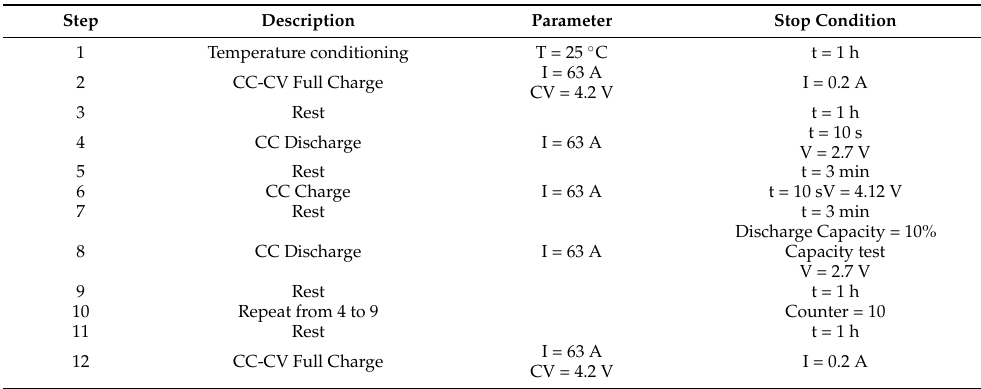
Table 5. Pulse test